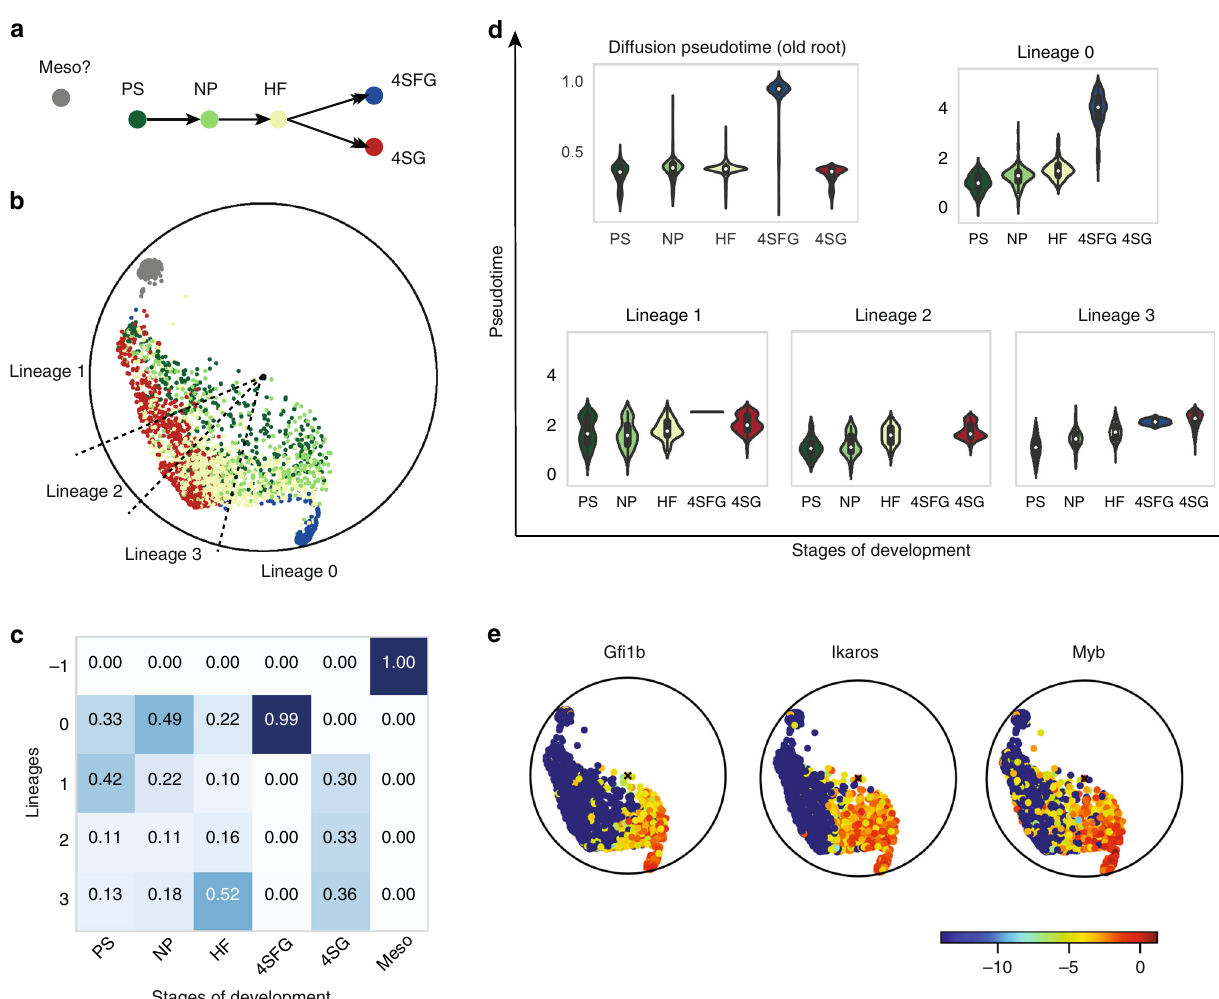
Fig. 4 Analysis of mice hematopoiesis with Poincaré maps. a Developmental hierarchy proposed by Moignard et al. 1 and Haghverdi et al. 16 . b Rotated Poincaré map with respect to reassigned root. Gray cluster represent a cluster of potential outliers or "mesodermal'' cells as suggested by Moignard et al. 1 . Lineage slices were obtained with Poincaré maps (see Methods). c Composition of detected lineages in terms of the presence of cells from different developmental stages. d Violin plots of diffusion and Poincaré pseudotime for each stage of embryo developmentt. The ordering of cells proposed by Poincaré maps here has a much better agreement with developmental stages than ordering originally proposed by Haghverdi et al. 16 : we see a very clear correlation of Poincaré pseudotime with actual developmental time. e Gene expression of main hemogenic genes. Hemogenic genes of erythroid lineage are already expressed at the PS and NP